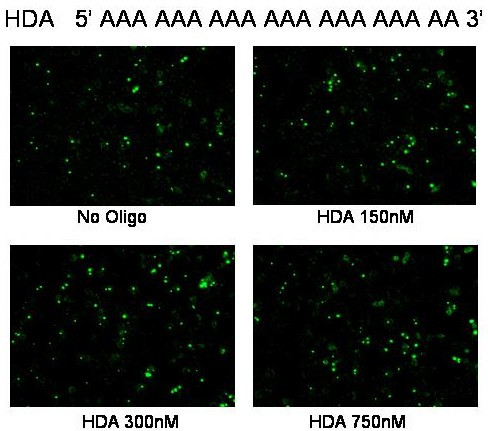
HDA was co-transfected at the indicated concentrations with p72Q and the cells were photographed 48 hours later in dark field.